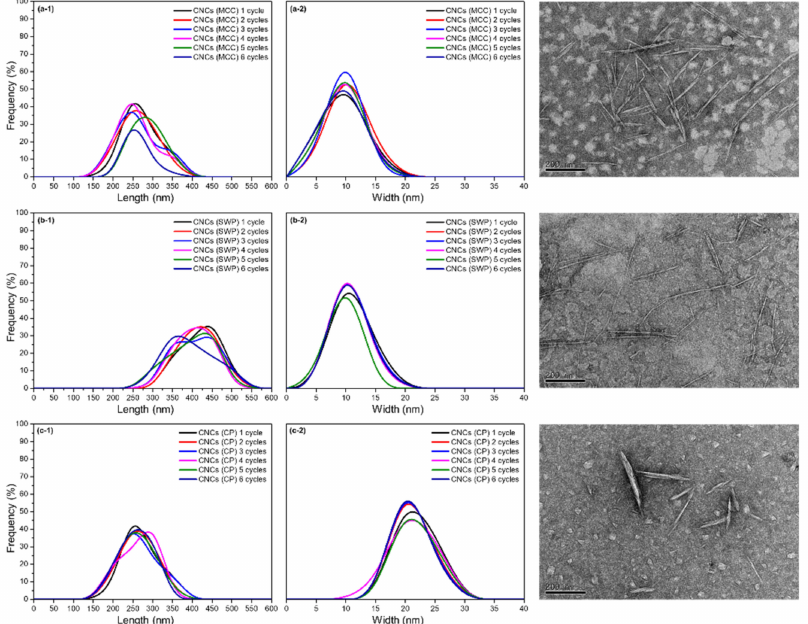
Figure 7. Size distribution histograms and TEM images of supernatant: ( a-1 , b-1 , c-1 ) length of CNCs (MCC, SWP, CP), ( a-2 , b-2 , c-2 ) width of CNC (MCC, SWP,